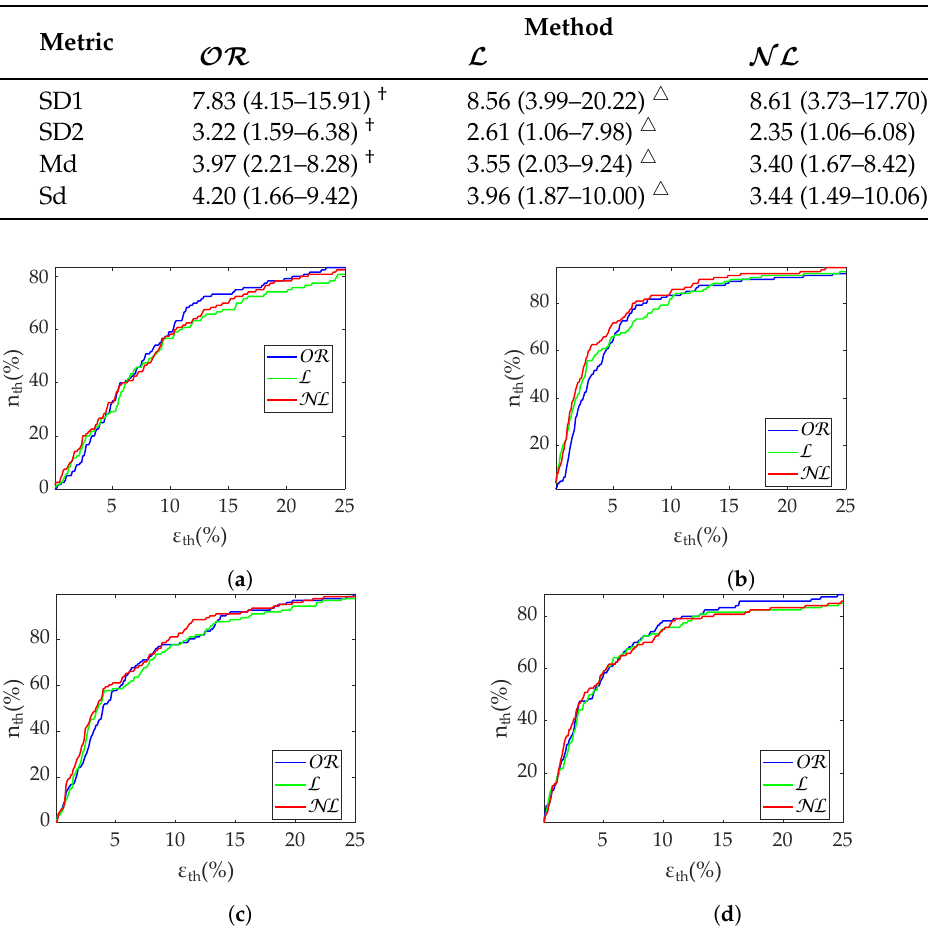
Table 12. Relative error (%) of Poincaré metrics from Apple Watch dataset. †: Significant differences ( p < 0.05) between OR and L . (cid:52) : Significant differences ( p < 0.05) between L and N L . §: Significant differences ( p < 0.05) between N L and OR .